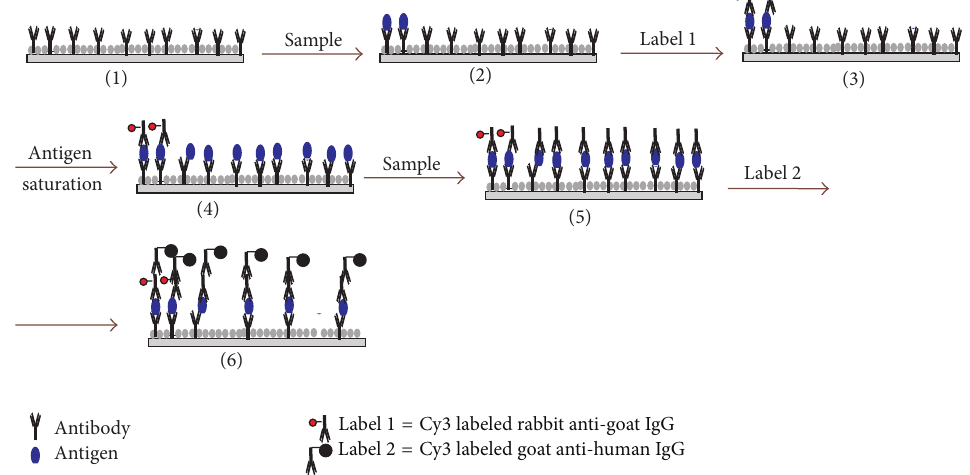
Figure 2: The procedures of this model diagnostic strategy in the